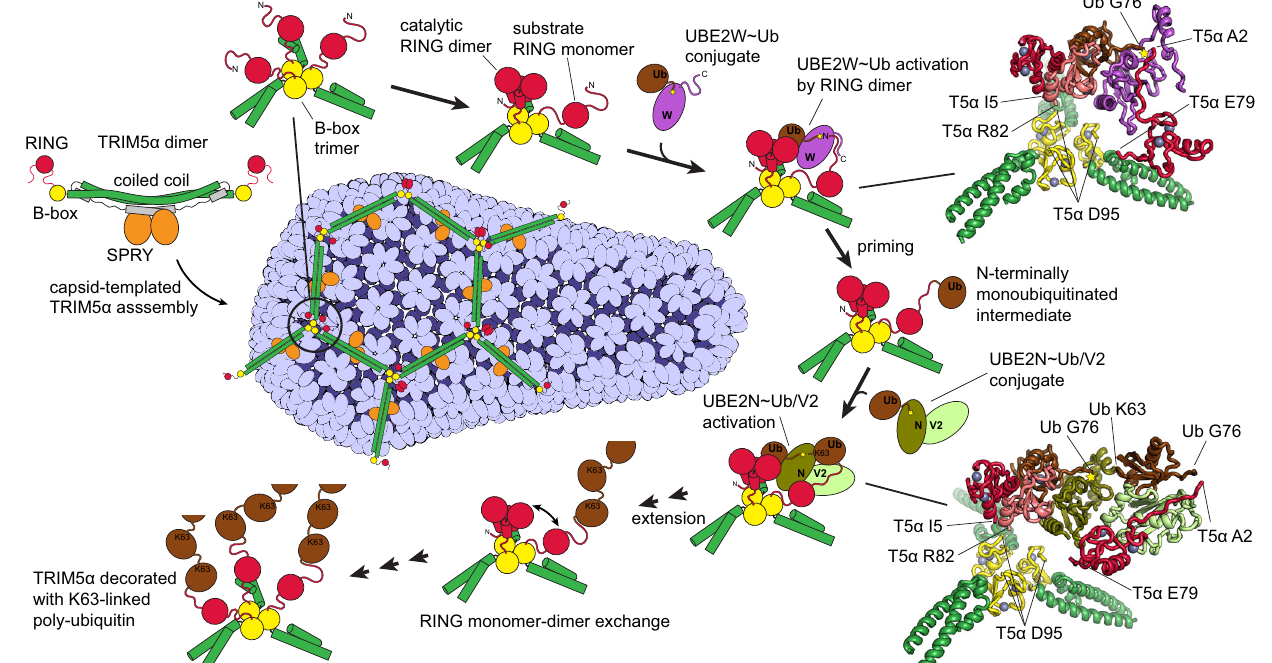
Fig. 5 | Transient proximity of three RING domains promoted by the associa- tion of TRIM5 α with the retroviral capsid explains how TRIM5 α auto- ubiquitylation is activated by capsid binding. The honeycomb-like TRIM5 α assembly on the surface ofthe retroviralcapsidisrequired for the antiviralactivity oftheprotein(seearecentcomprehensivereviewfordetailedbibliography 10 ).The architecture of the TRIM5 α assembly suggests that the cooperativity between SPRY:capsid interactions and B-box:B-box interactions forms the basis of the pat- tern recognition functionality and promotes capsid binding 22 . B-box trimerization at the vertices of the TRIM5 α honeycomb brings three N-terminal RING domains intoproximity. Herewe show thatproximity of three RINGs createsanasymmetric structural arrangement, which explains how RING can act as both the catalytic activatorandthesubstrateintheubiquitintransferreactions.Fluorescentubiquitin dischargeassaysrevealthatproximityofthreeRINGsstronglyenhancestheratesof